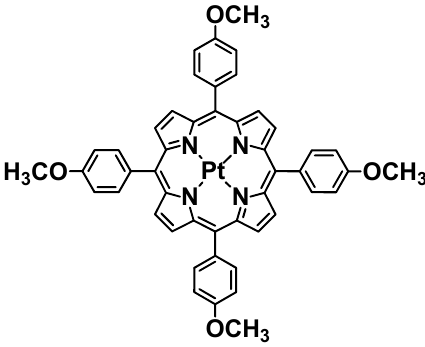
Figure 1. Structure of Pt(II) 5,10,15,20-tetra(4-methoxy-phenyl)-porphyrin (PtTMeOPP).